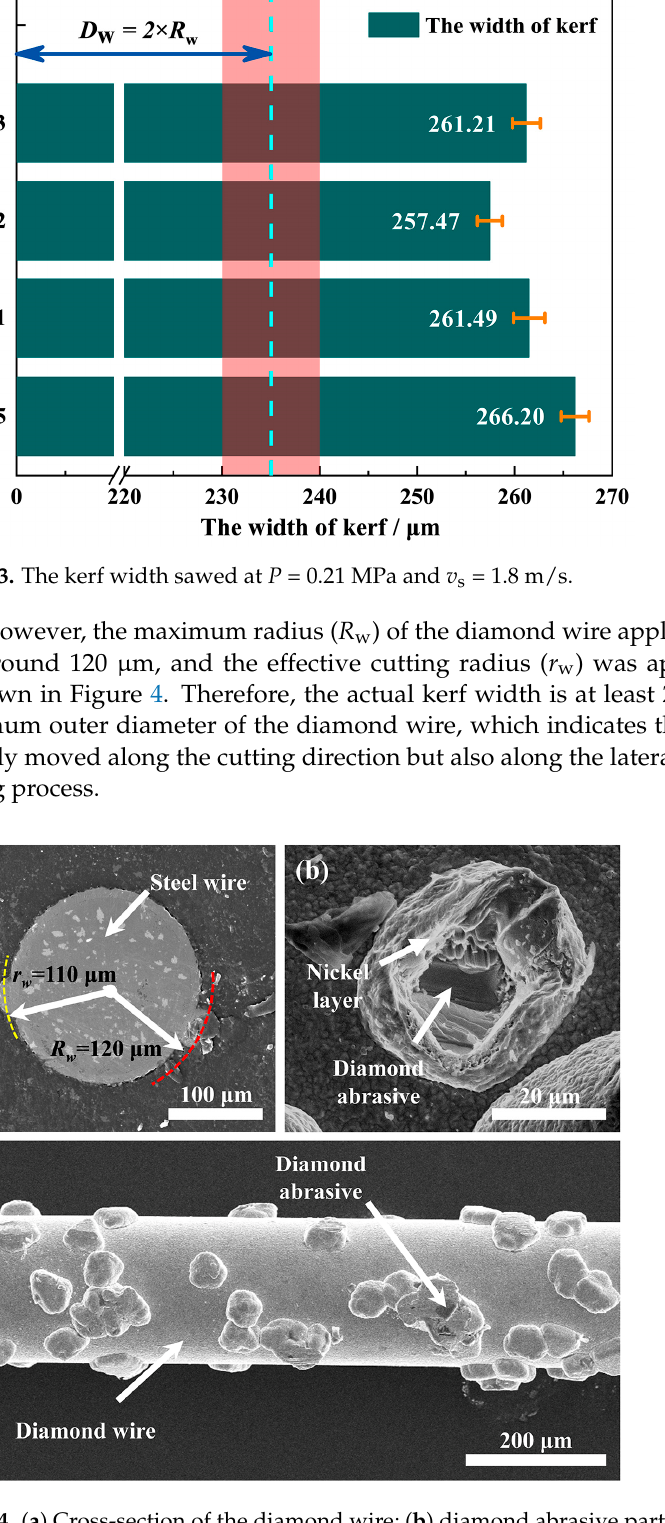
Figure 4. ( a ) Cross-section of the diamond wire; ( b ) diamond abrasive particle; ( c ) a full view of the diamond wire with diamond abrasives.